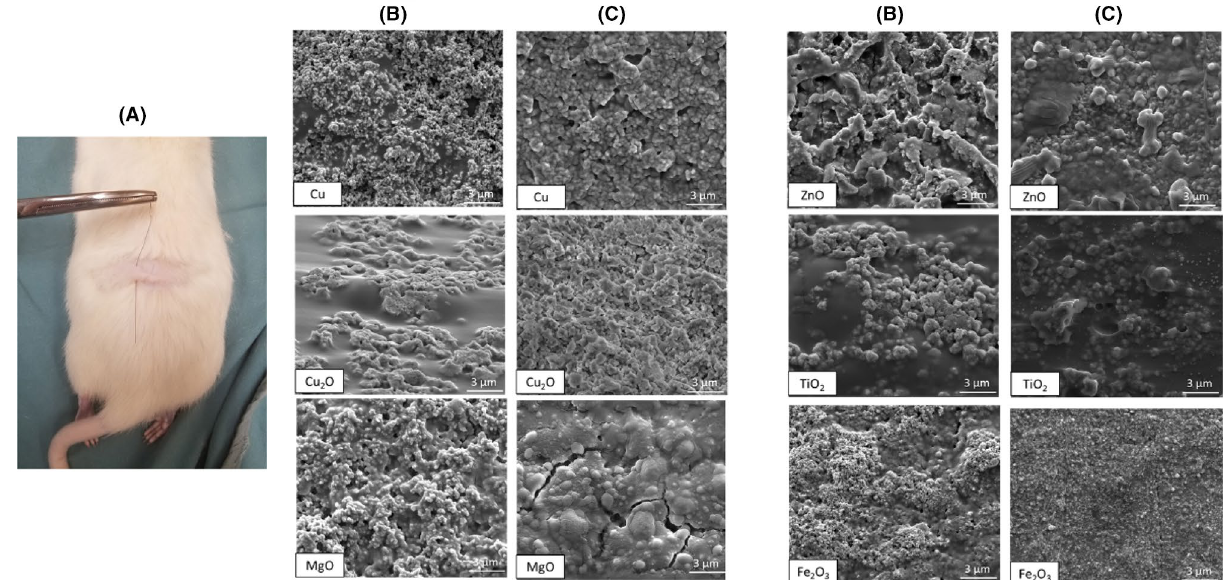
Figure 2. ( A ) The skin model confirmed the retention of NPs by the silk layer on the suture. SEM images showing the nanoparticle coating ( B ) before and ( C ) after pull test results.